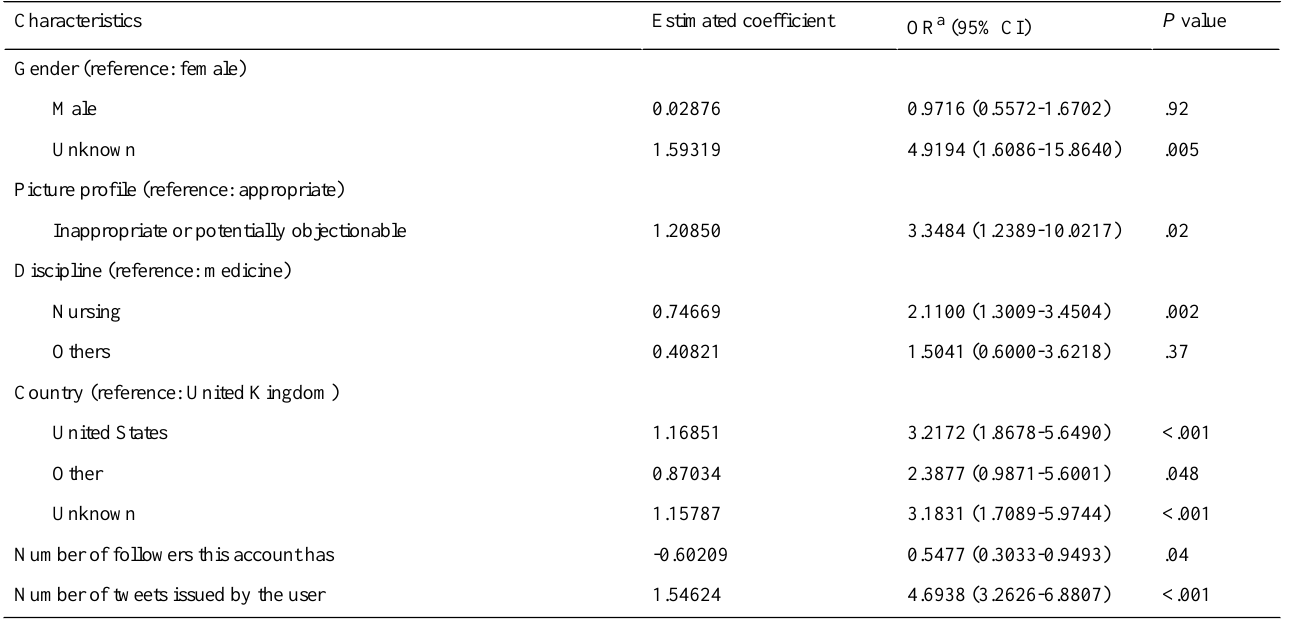
Table 3. Association of Twitter account characteristics with presence of cyberincivility through logistic regression fit. Gender (reference: female)